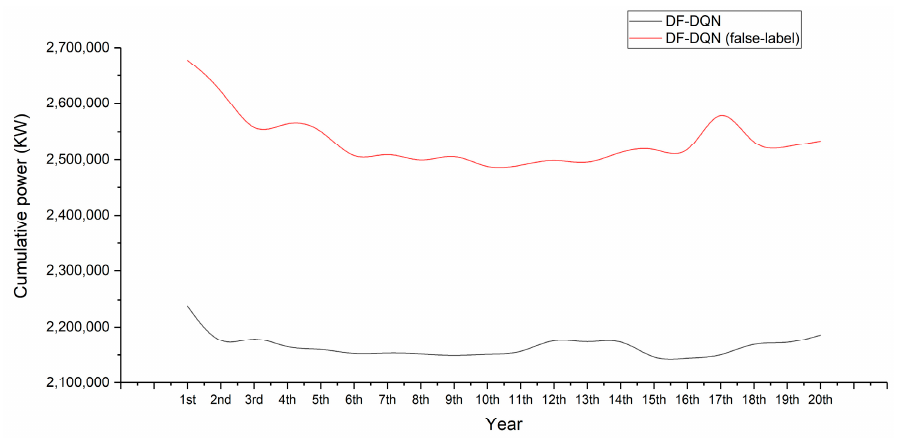
Figure 11. Comparison of COP between DQN and DF-DQN.